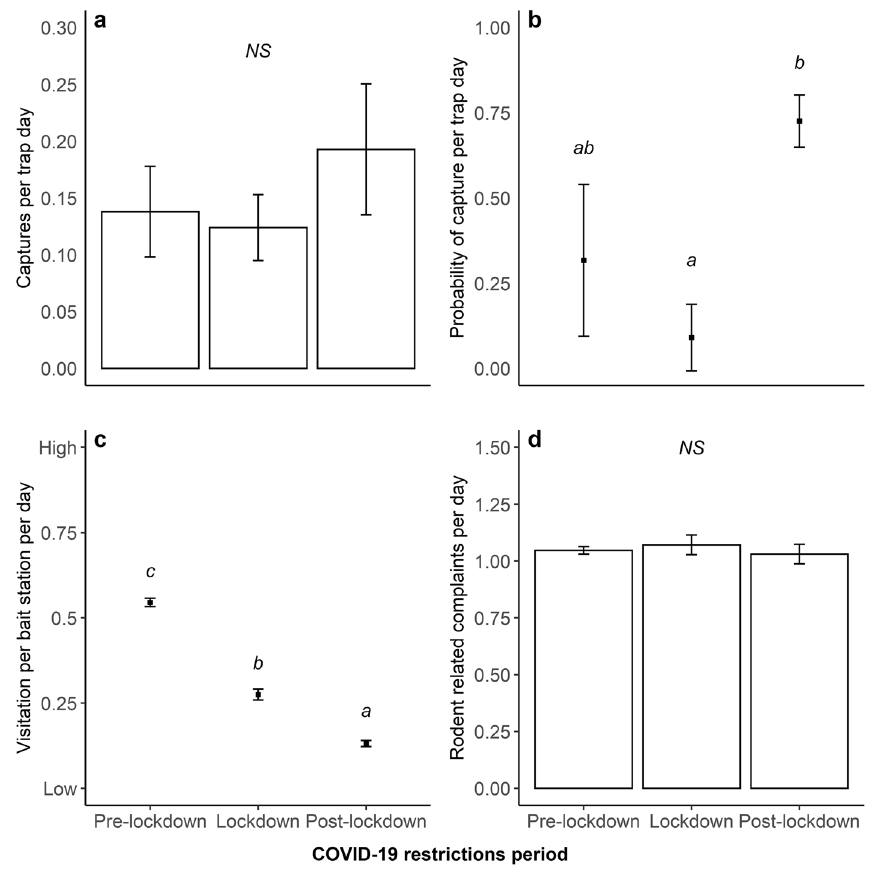
Figure 1. Rodent captures per trap day ( a ), probability of rodent captures per trap day ( b ), rodent visitation at bait stations ( c ) and rodent related residents’ complaints ( d ) recorded by the Council of the City of Sydney, prior during and post COVID-19 restrictions and social distancing measures imposed by the New South Wales State government (Mean ± SE). Superscripts represent Tukey-adjusted pairwise comparisons (α =